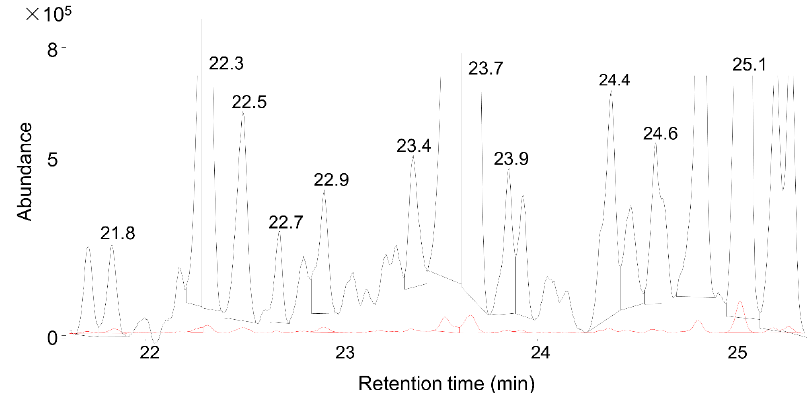
Figure 3. Difficulties during compound integration. The black line denotes P6h measures, and the red line denotes P1h measures. Some relevant compounds are marked with their retention times. It was complicated to find some compounds at short sampling times (1 and 2 h).